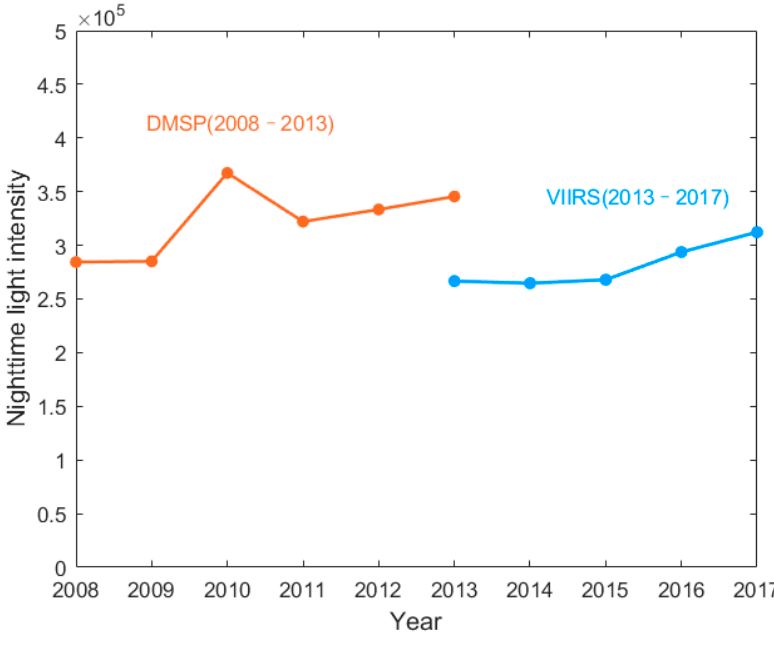
Figure 2. Total DN value of nighttime light in Beijing before processing.